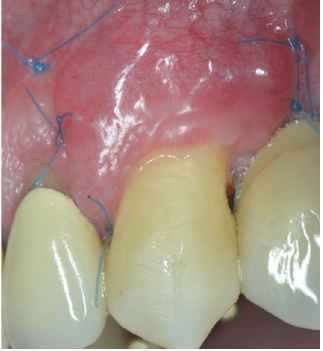
Figure 12: Healing of the fl ap after 15 days, at sutures